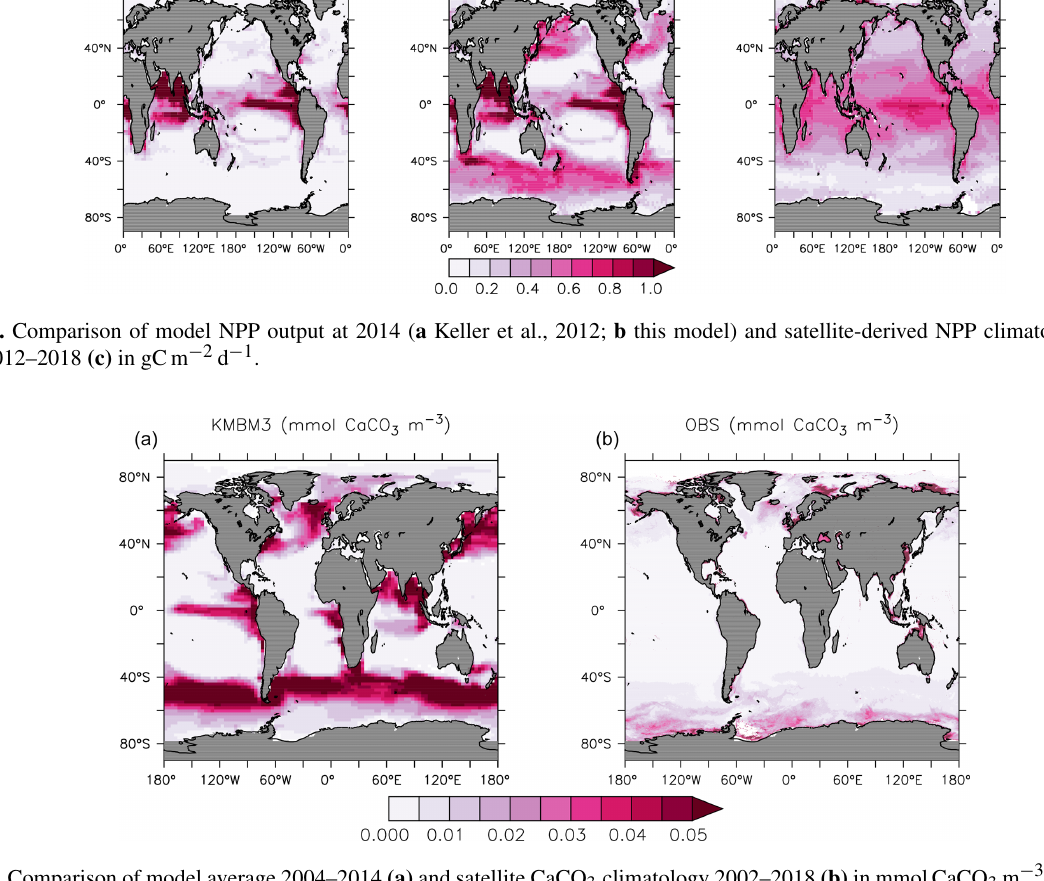
Figure 4. Comparison of model average 2004–2014 (a) and satellite CaCO 3 climatology 2002–2018 (b) in mmolCaCO 3 m − 3 . Data product is scaled by the model grid in the z direction, and in both plots only the upper 20m are represented, where uniform coccolith concentration is assumed (Balch and Utgoff,